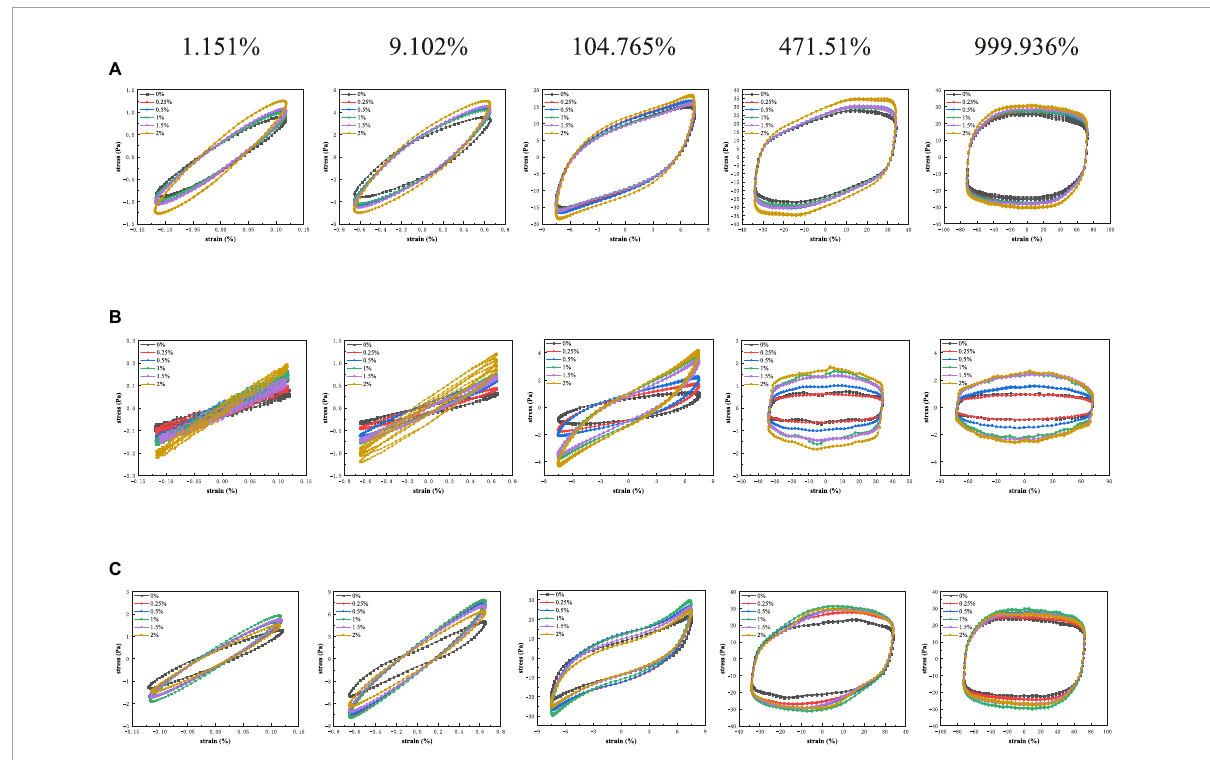
FIGURE5 Lissajous curves of stress versus strain amplitude for PPI with different TG concentrations at (A) 30 ◦ C, (B) from 30 to 120 ◦ C and (C) from 30 to 120 ◦ C and then cooled to 30 ◦ C.